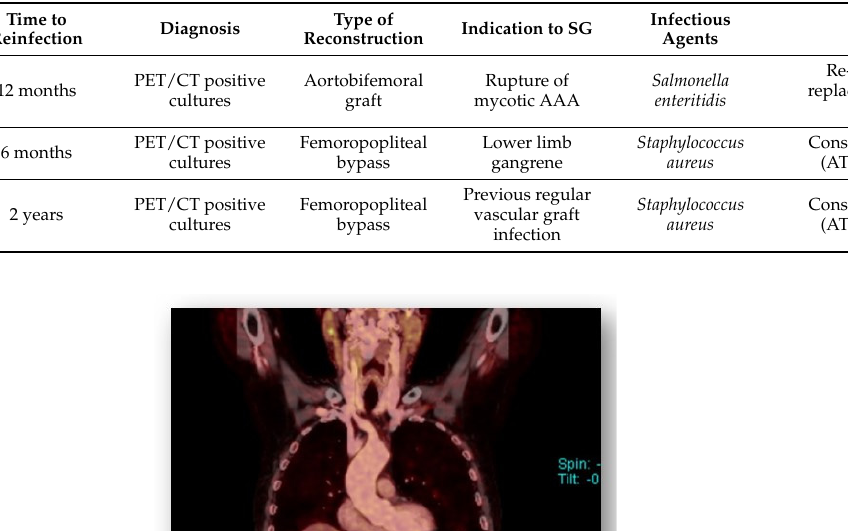
Table 3. Data of patients with silver graft infections.